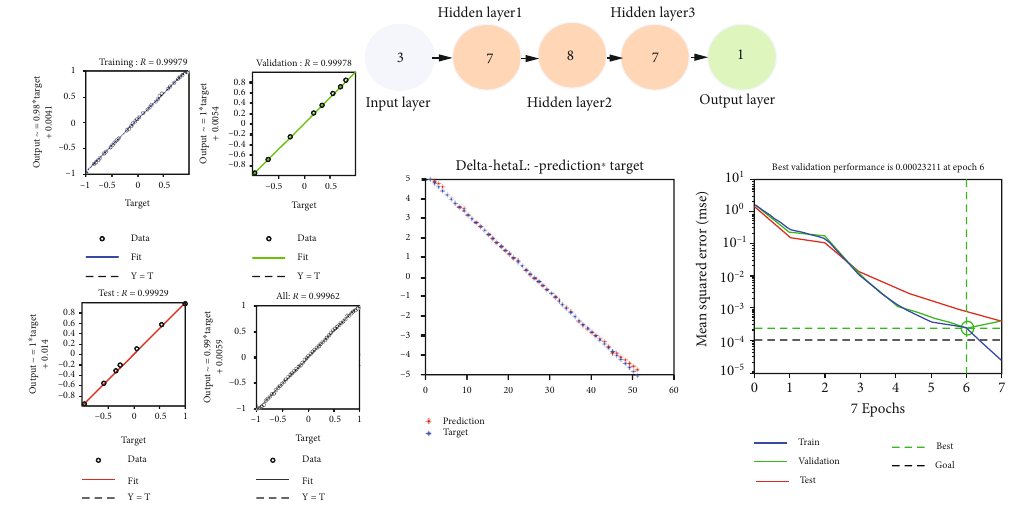
Figure 10: Training results of fl ight path angle neural networks.